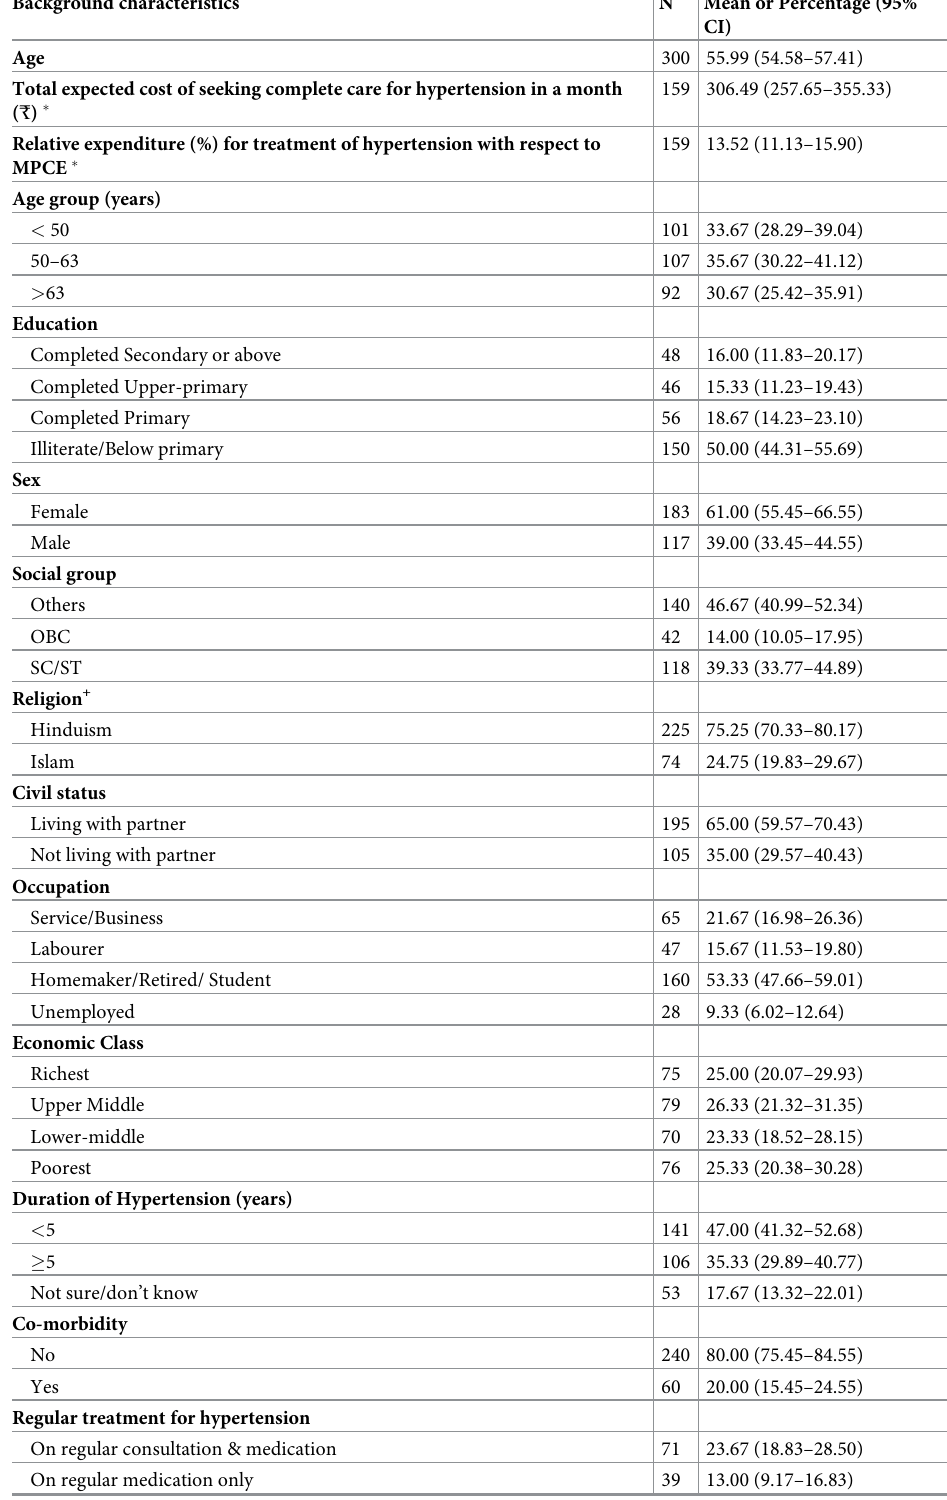
Table 1. Characteristics of the study participants (N =